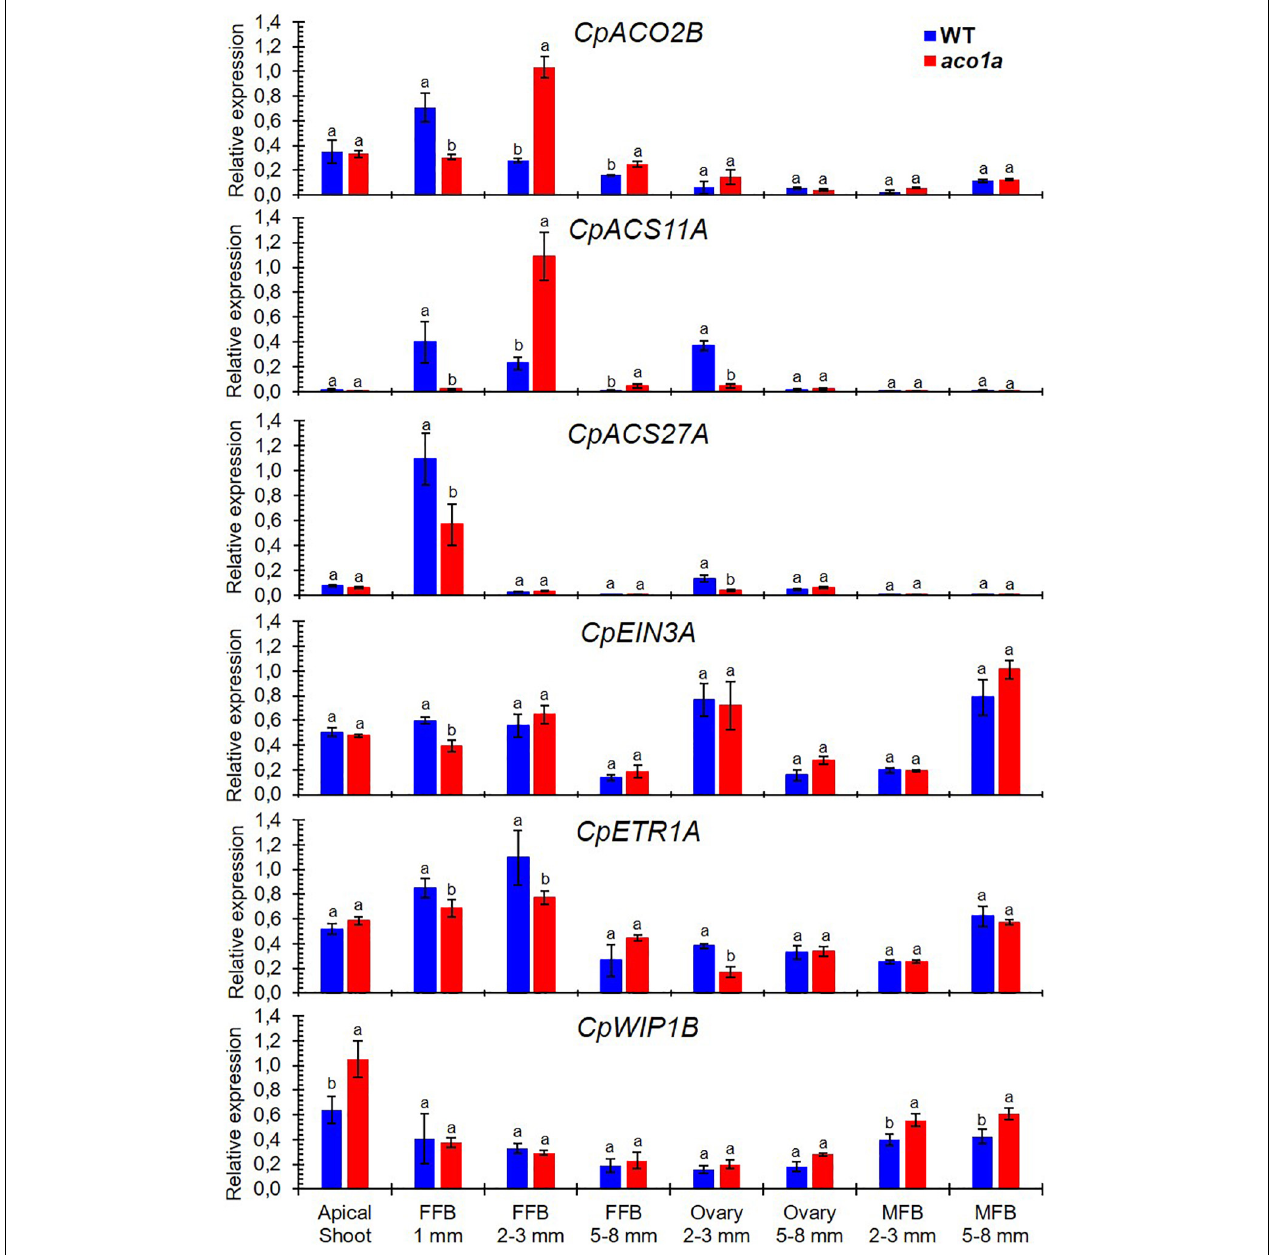
FIGURE 7 | Relative expression of different sex-determining genes in the apical shoots and flowers of WT and aco1a plants. The expression was assessed for genes involved in ethylene biosynthesis ( CpACO2B , CpACS11A , and CpACS27A ), ethylene perception and signaling ( CpETR1A and CpEIN3A ), and coding for the transcription factors ( CpWIP1B ) that are known to be involved in sex determination in cucurbit species. The relative level of each transcript was quantified by quantitative PCR in three independent replicates of each tissue. FFB, female floral bud excluding the ovary; MFB, male floral bud. Error bars represent SE. Different letters indicate significant differences between WT and mutant apical shoots and flowers at the same stage of development ( p ≤